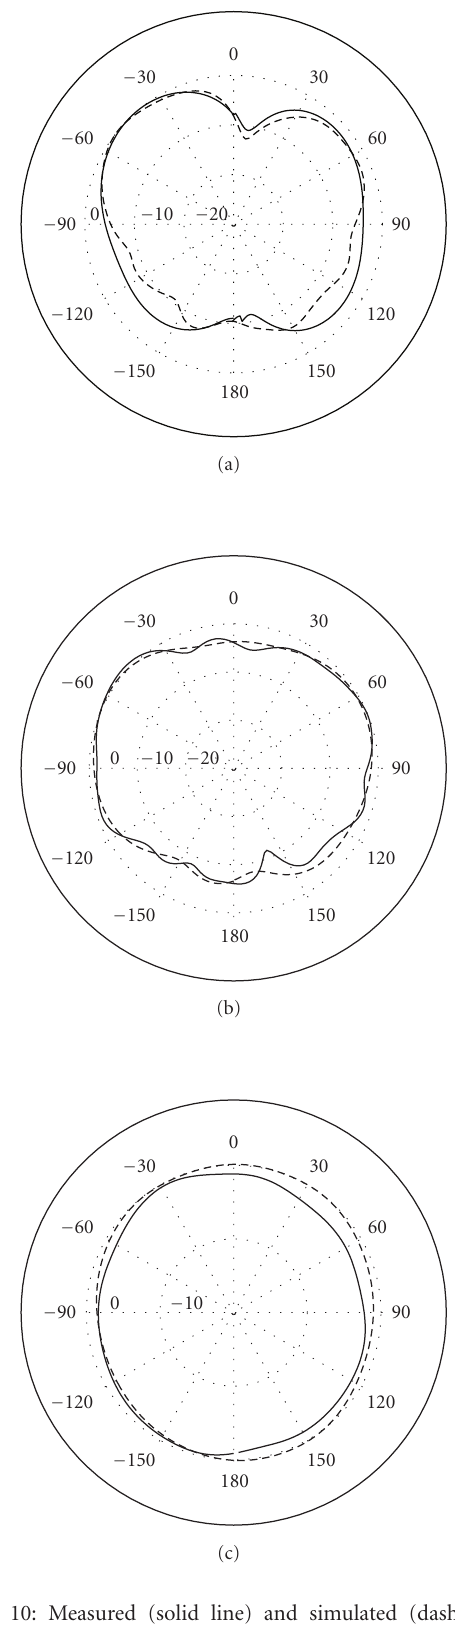
Figure 9: Measured (solid line) and simulated (dashed line) radiation patterns at 2.44 GHz: (a) x - z plane, (b) y - z plane, and (c) x - y plane.